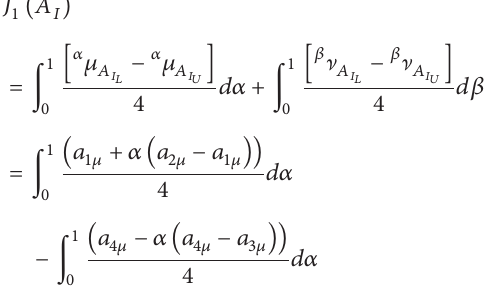
𝑓 ≤ 𝑏 𝑓 ≥ 𝑏 𝑒 ≤ 𝑎 , and 𝑔 ≥ 𝑐 on the legs of trapezoidal 1 1 , 2 2 , intuitionistic fuzzy